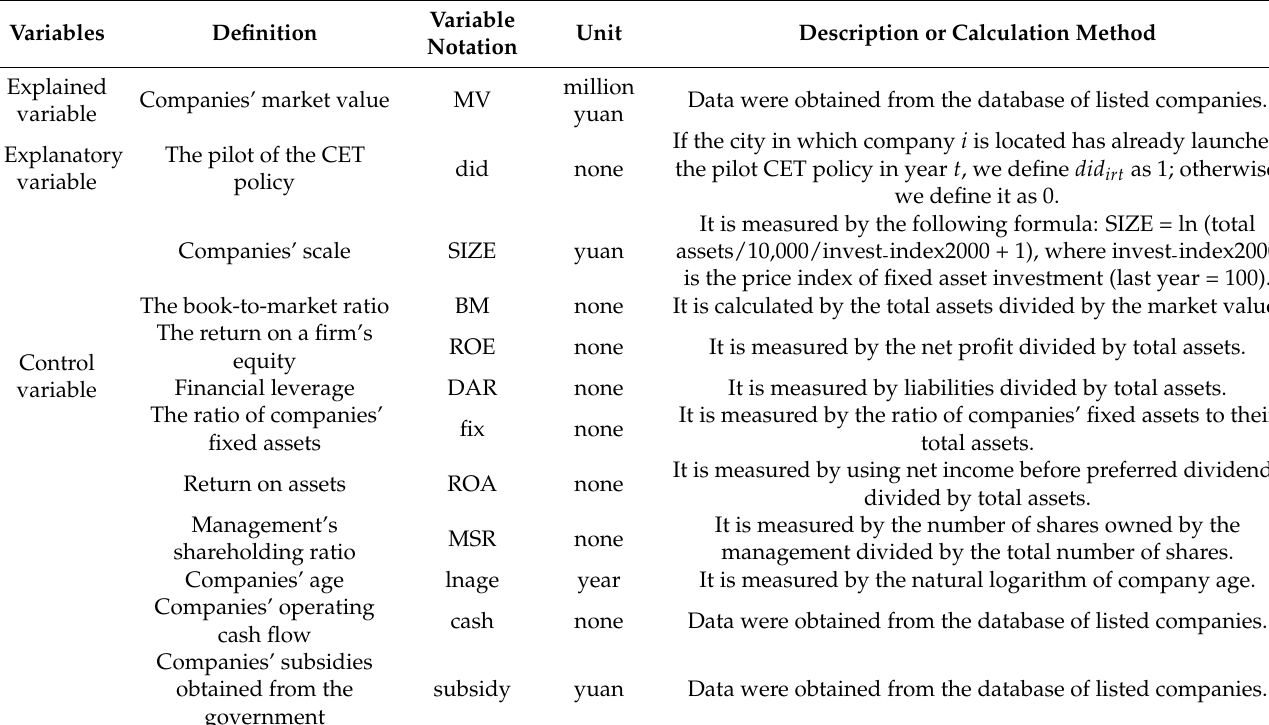
Table 2. Variables and data descriptions.